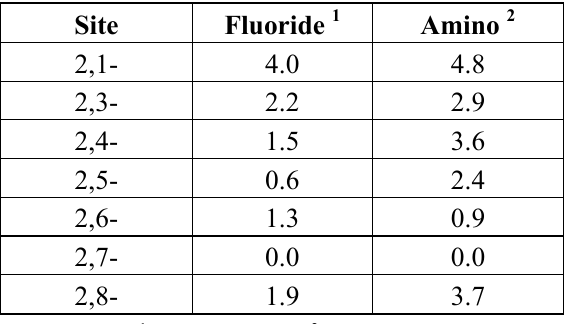
Table 1. Relative Energies (kcal/mol) of the various Meisenheimer complexes for